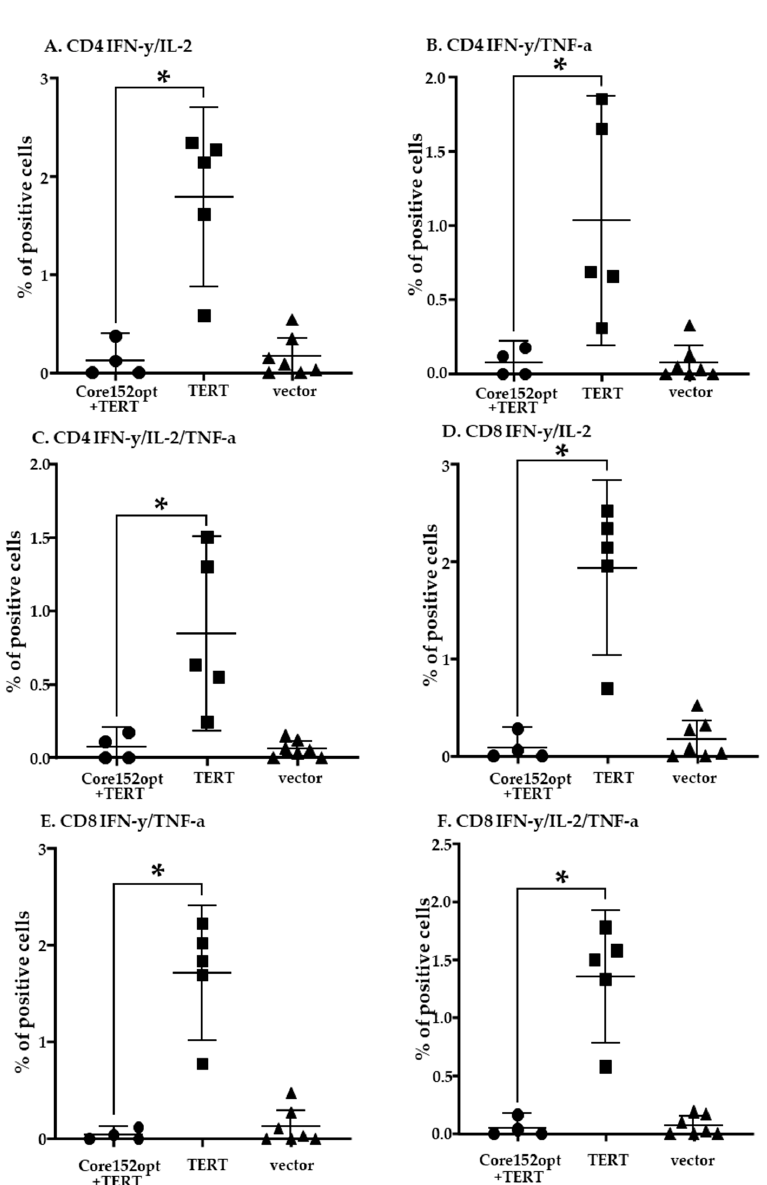
Figure 5. Cellular immune response against TERT in mice DNA immunized with TERT compared to TERT mixed with HCV Core152opt (Series II, Table 1). Comparison of percent of CD4+ ( A – C ) and CD8+ ( D – F ) cells responding to stimulation with peptide pool TERT357 (Supplementary Table S1) by production of IFN- γ /IL-2 ( A , D ), IFN- γ /TNF- α ( B , E ), IFN- γ /IL-2/TNF- α ( C , F ). Data from is presented as mean ± 95% CI. Statistical analysis is by Kruskal-Wallis and F-tests: CD4+ T cells: IFN- γ /IL- 2: F(2,13) = 7.8551, p = 0.0058; KW-H(2,16) = 8.1131, p = 0.0173 ( A ); IFN- γ /TNF- α : F(2,13) = 3.8197, p = 0.0496; KW-H(2,16) = 7.4213, p = 0.0245 ( B ); IFN- γ /IL-2/TNF- α : F(2,13) = 4.1375, p = 0.0407;